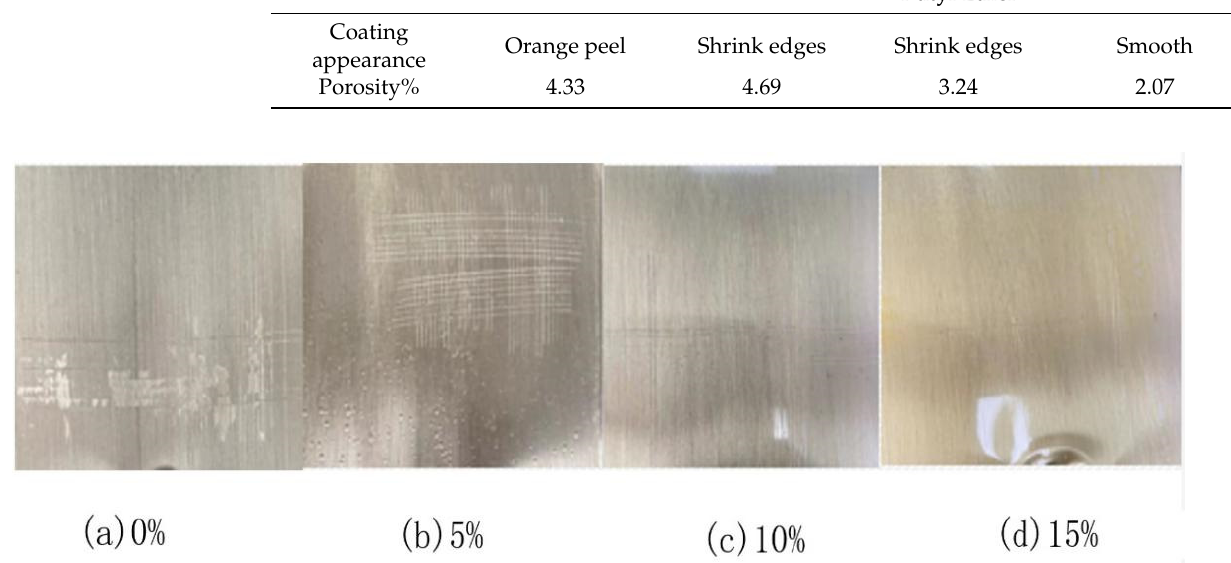
Figure 8. Coated surface with different contents of mesityl oxide: ( a ): 0%, ( b ): 5%, ( c ): 10%, ( d ): 15%.